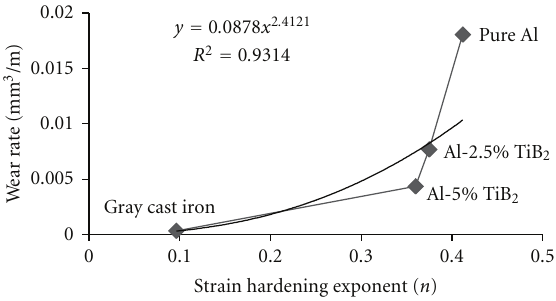
Figure 16: E ff ect of strain hardening exponent on wear rate of